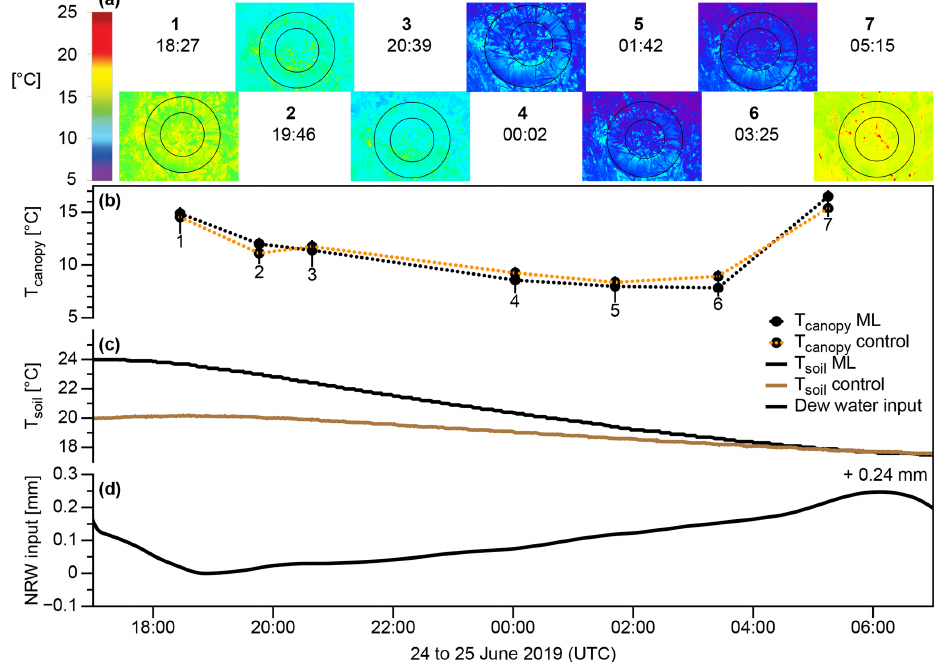
Figure 5. Canopy temperatures (a, b) , soil temperatures (c) , and NRW input (d) of ML1 and the control (surrounding area) at CH-FRU during 24 to 25 June 2019. Time of day (HH:MM) is given in UTC time. The thermal infrared images (a) show the ML pot (small circle) with the cover lid (between the small circle and the big circle) and the surroundings (outside of the big circle) during selected time points (1–7) of a dew night. Image size is ca. 75 × 75cm. To compare ML pot temperatures to temperatures of the surroundings, separate images were taken at a distance of ca. 100cm (images not shown here) with a size of ca. 75 × 75cm to exclude any potential influence of the ML on its approximate surroundings.